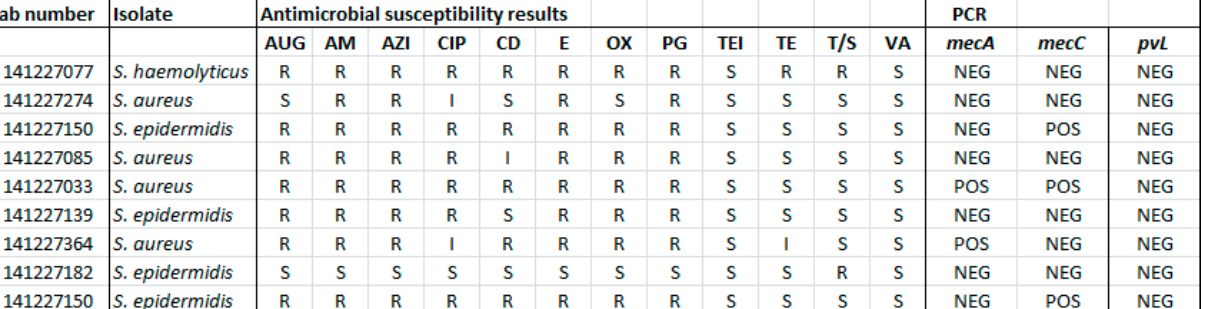
Figure 2. Antimicrobial susceptibility pattern; PCR results for mecA , mecC and pvL genes among representative Staphylococcus